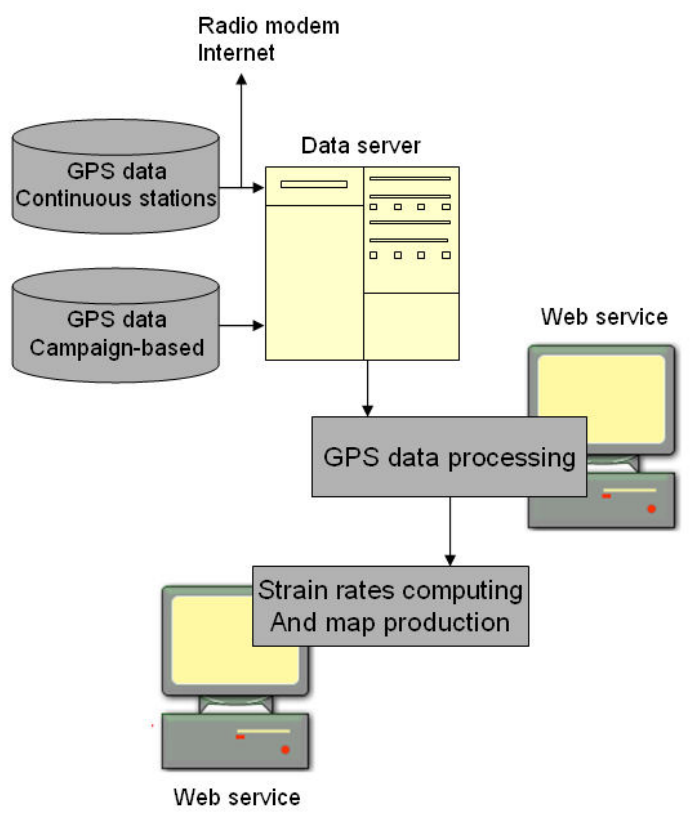
Figure 4. Data transfer and processing